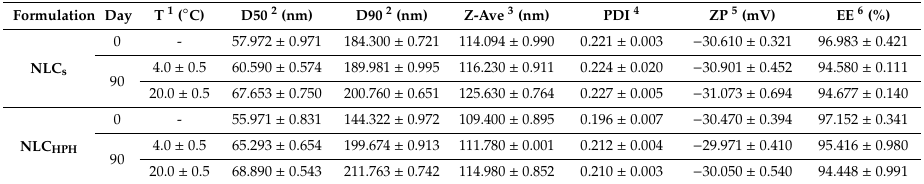
Table 7. Results of the stability studies of rivastigmine-loaded nanostructured lipid carriers (NLC) formulations prepared by ultrasound technique and high-pressure homogenization (HPH) method.